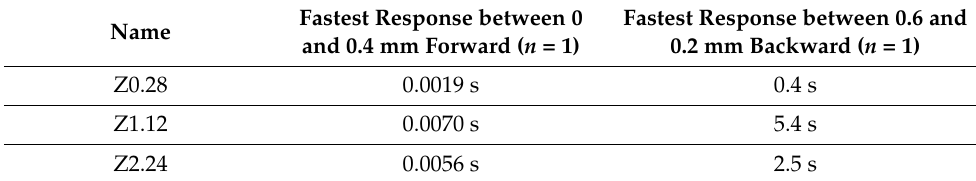
Table 5. Fastest response times obtained for half of the 0.8 mm